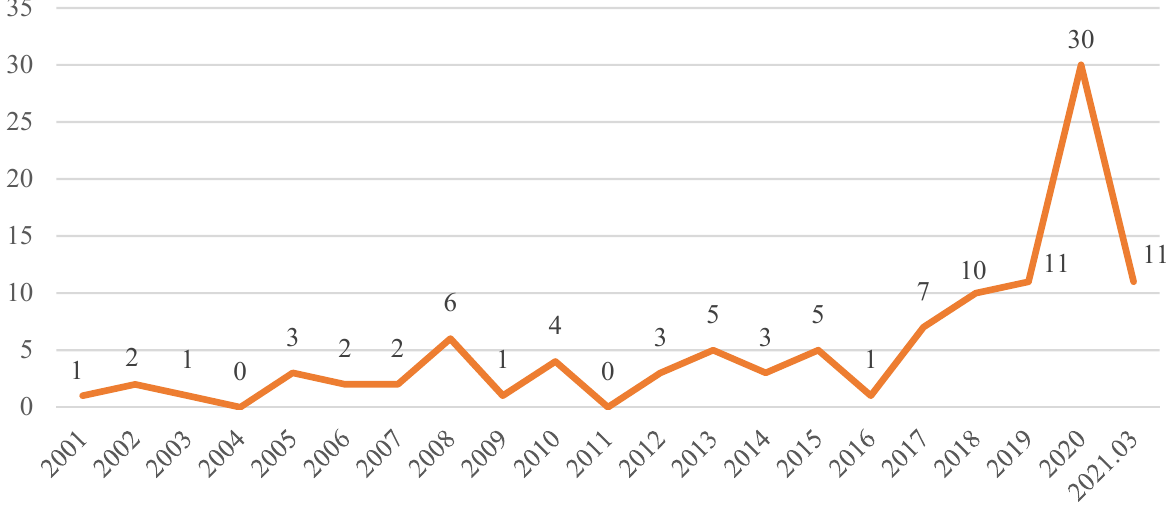
Figure 1. Trend of mobile communication technology research in hospitality and tourism.